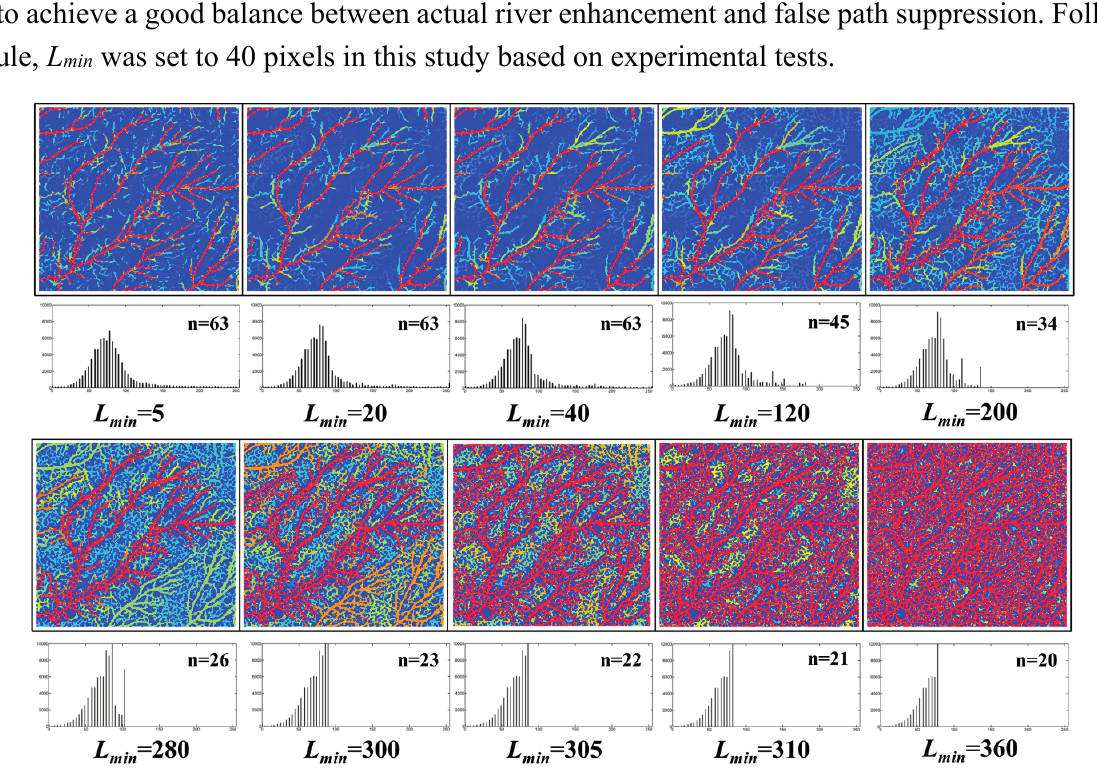
Figure 5. Path-opening results and their corresponding gray histograms under different L min settings. n is the total number of gray levels in each image. The intensities of all the images are rescaled to [0, 255] and showed in a blue-red color ramp for better display and comparison. Blue indicates lower